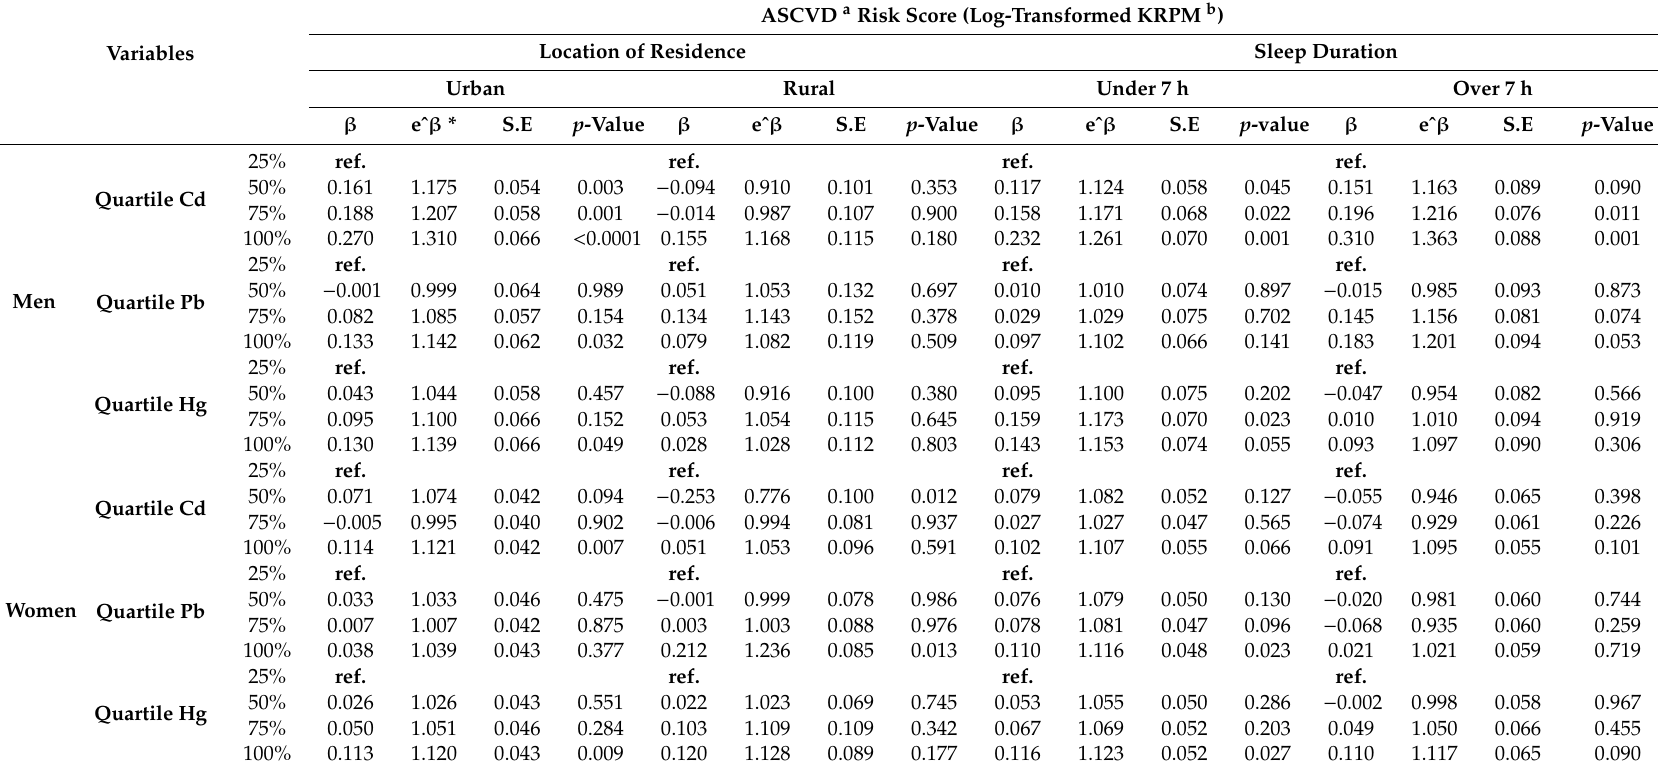
Table 3. Subgroup analysis of the e ff ect of the blood heavy metal